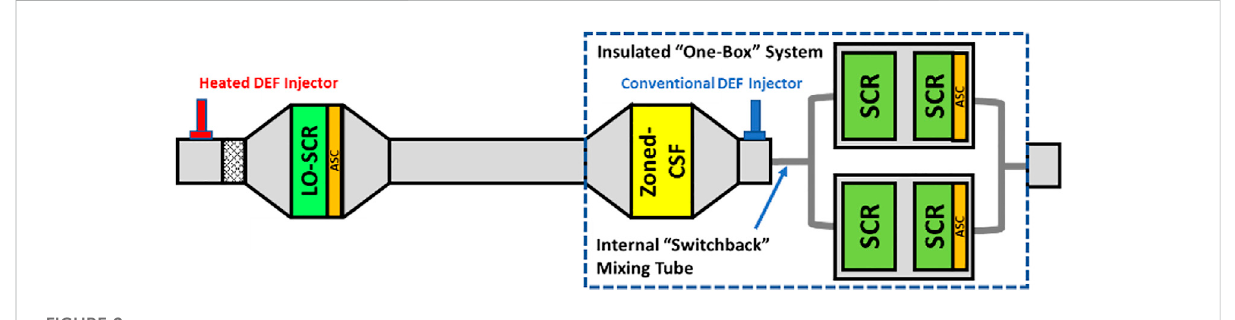
FIGURE 2 Baseline system schematic of the CDA + LO-SCR + Primary system.